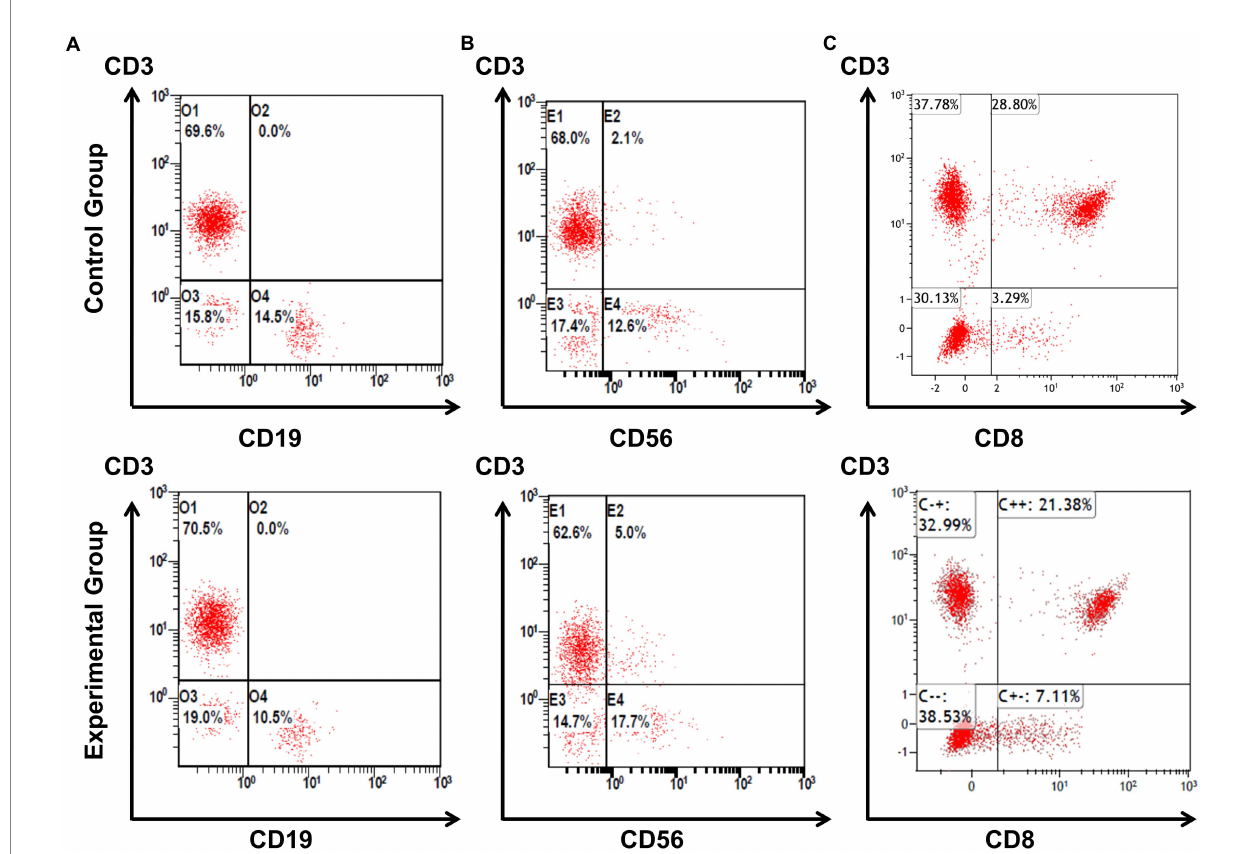
FIGURE 1 The main differences of percentages of lymphocyte subsets between experimental and control group. Frontline medical workers for treating patients of COVID-19 had significantly lower percentages of CD19 + B cells compared to control group, the representative results of flow cytometry are shown as line (A) . Compared with control group, stratification analysis showed that the percentages of CD56 + NK cells were higher in the aged ≥ 40 years subgroup, the representative results of flow cytometry are shown as line (B) . Stratification analysis also showed that the percentages CD8 + T cells were lower in the aged ≥ 40 years subgroup compared to control group, the representative results of flow cytometry are shown as line (C) .